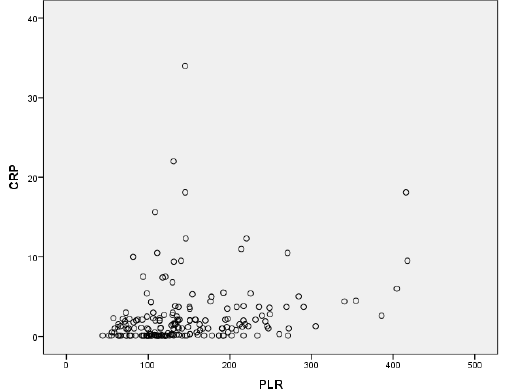
Figure 1. Correlation between CRP and